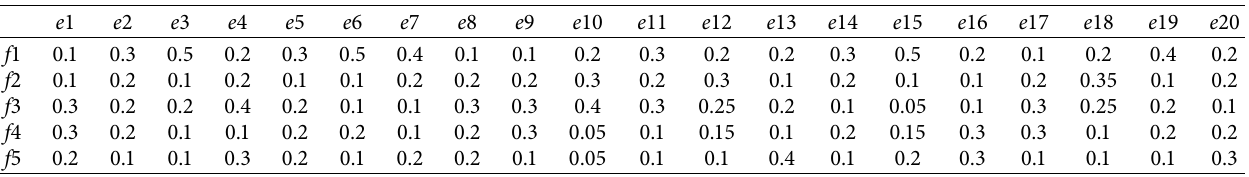
Table 28: .e initial subject weight vector w m of the DM em ( m � 1, ... , 20).